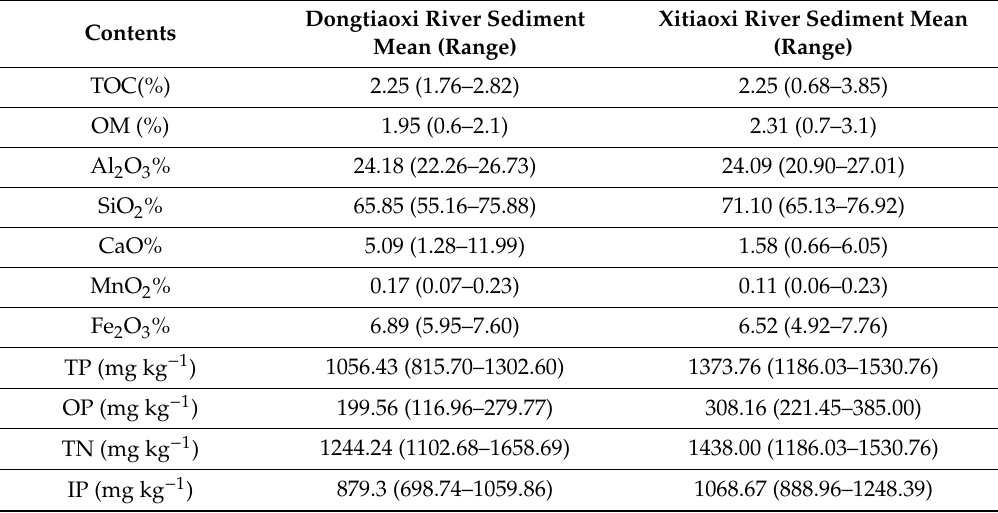
Table 2. Physical and chemical characteristics of sediment properties of Dongtiaoxi River and Xitiaoxi